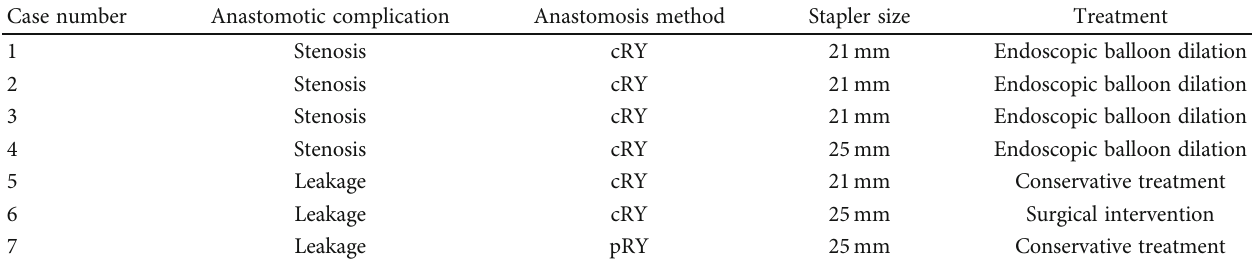
Table 4: The characteristics of cases with anastomotic